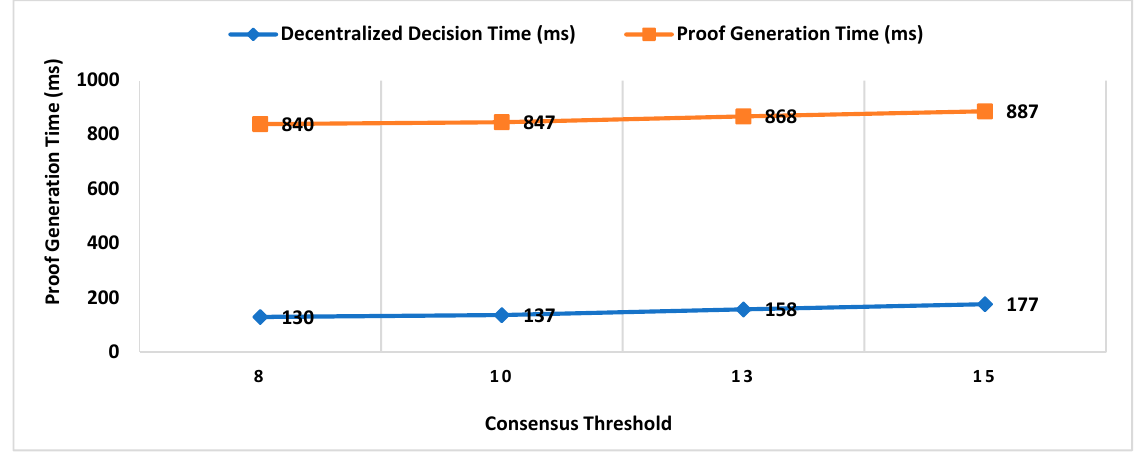
Figure 6. Consensus threshold impact on the decentralized decision time and proof generation